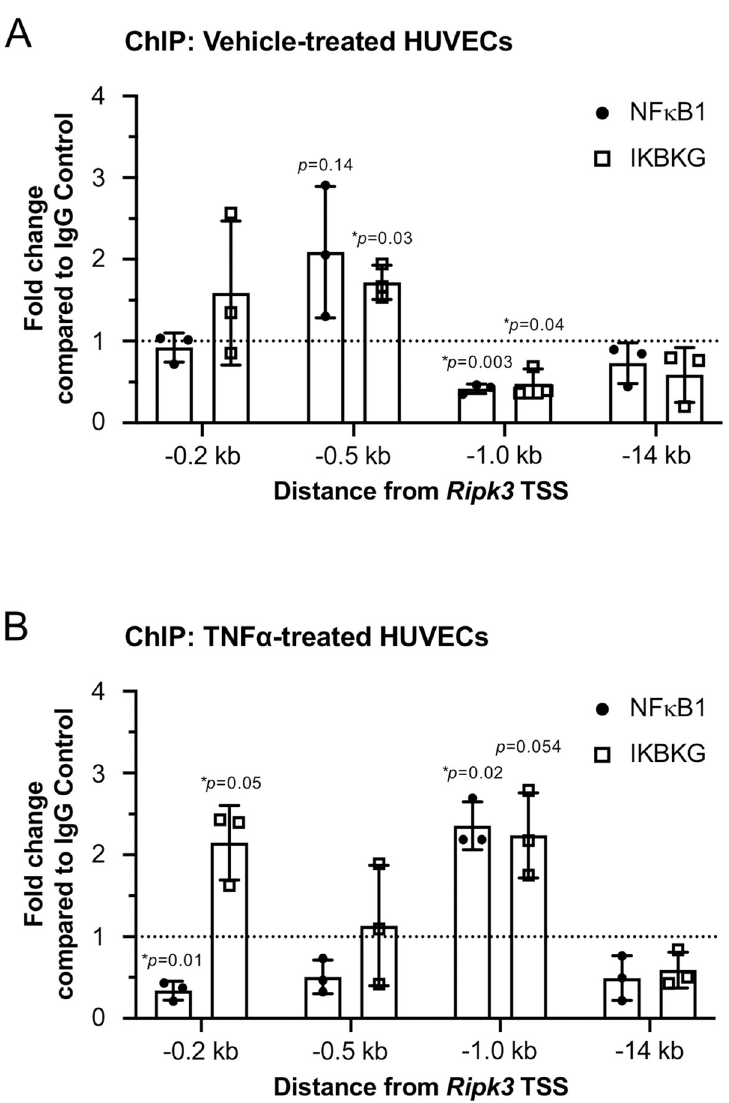
Fig 4. NF κ B1 and IKBKG bind to the Ripk3 promoter in HUVECs. ChIP assays using antibodies against NF κ B1, IKBKG, or against rabbit IgG (as a negative control) were performed in HUVECs. Prior to ChIP, HUVECs were treated with vehicle (PBS) or TNF α (100 ng/mL) for 24 hr (A and B, respectively). Immunoprecipitated DNA was isolated and measured by qPCR to determine whether NF κ B1 and IKBKG bound the Ripk3 promoter at the regions indicated on the X-axes. Three sets of experiments were performed independently. Data are graphed as the average fold change of enrichment at the indicated sites compared to the normalized average of IgG (negative control antibody) enrichment at each of those sites (dotted line). Error bars represent S.D. All statistics were calculated using a one-sample t and Wilcoxon test. ( � ) indicates statistical significance ( p <